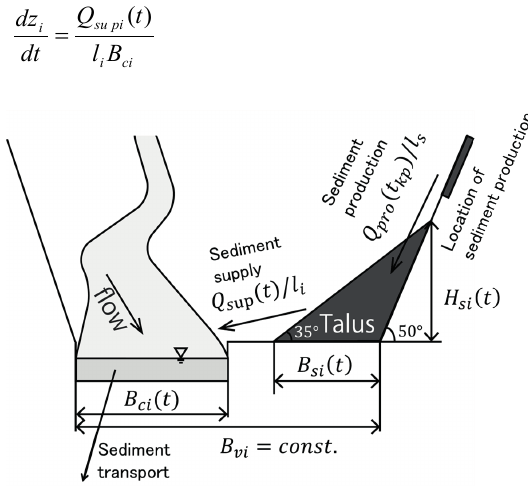
Fig. 3 Concept of the talus erosion